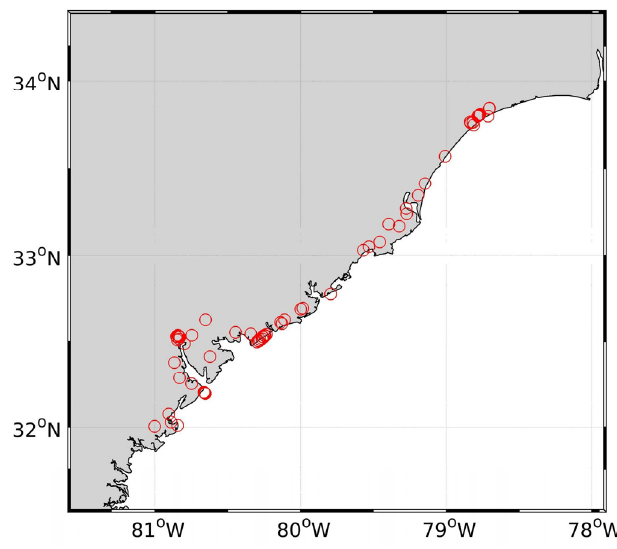
Figure 1. Locations of each years’ maximum storm surge height during 1851–2018.